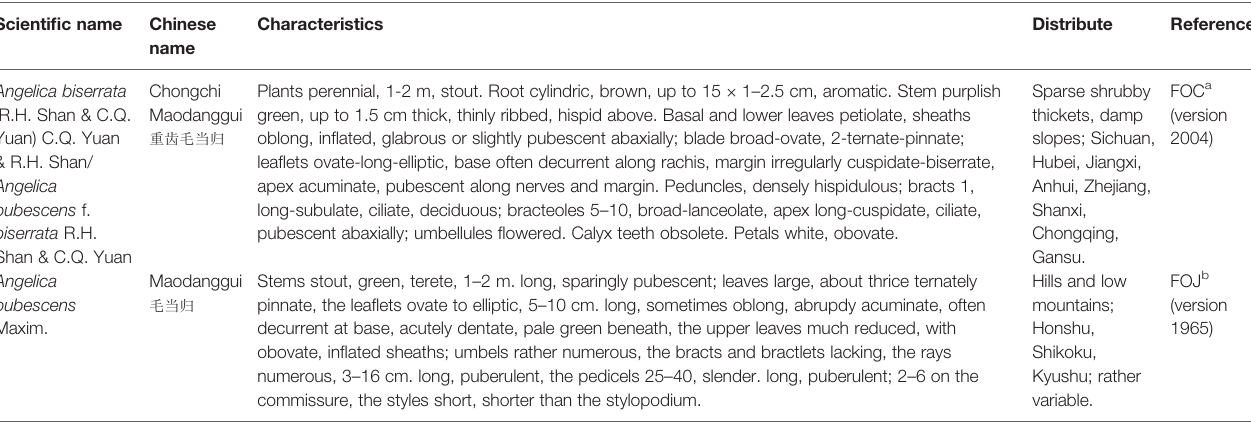
TABLE 1 | The Characteristics and Distribution of medicinal plants as